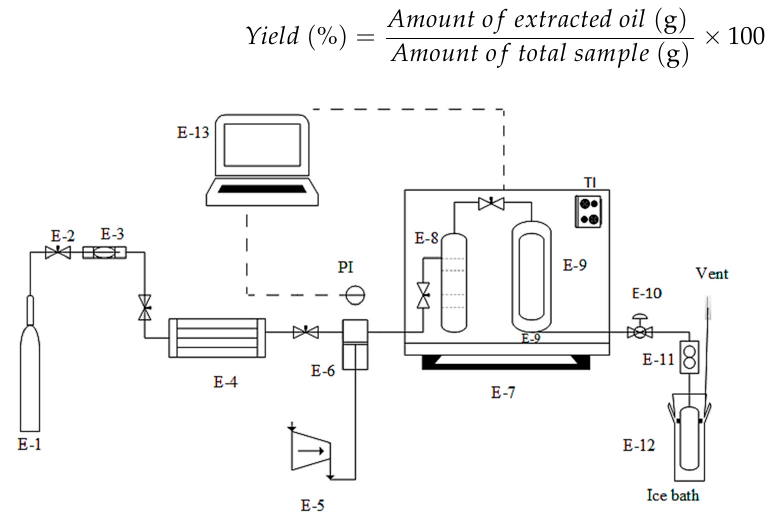
Figure 1. Schematic representation of the supercritical CO 2 extraction set-up. E-1: CO 2 cylinder; E-2: Needle valve; E-3: Filter; E-4: Refrigerator unit; E-5 Compressor; E-6: High pressure pump; E-7: Oven; E-8: Surge tank; E-9: Extraction cell; E-10: Back pressure; E-11: Micro metered valve; E-12: Sampler; E-13: Automation.